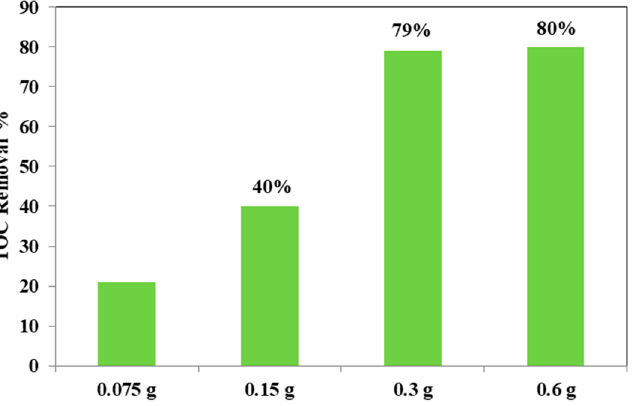
Figure 13. TOC removal (%) from the AO7 aqueous solution after 180 min of visible irradiation using different loads of optimized Fe(2.5)-TiO 2 photocatalyst.